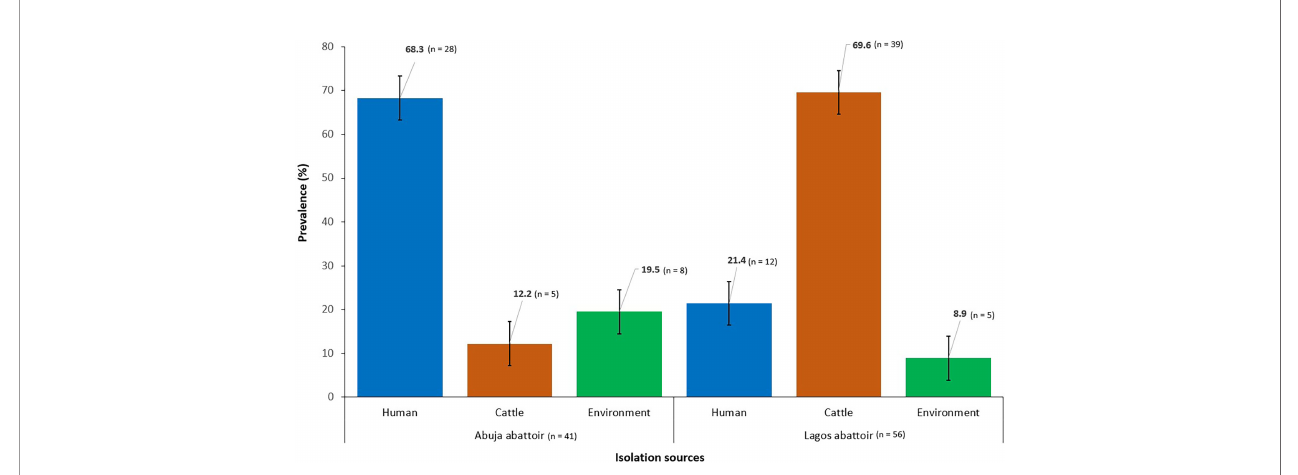
FIGURE 1 | Prevalence of ESBL-EC isolated from humans, cattle, and abattoir environments in Abuja and Lagos Nigeria, 2021. Bars represent the proportion of ESBL-EC isolates from each isolation source with 95% con fi dence intervals. Error bars represent standard error of the mean prevalence. Data were obtained from two sources: Abuja and Lagos